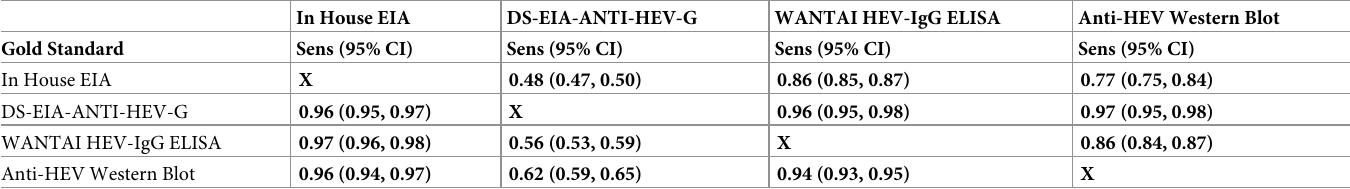
Table 3. Comparative sensitivity of HEV assays from NHANES III.